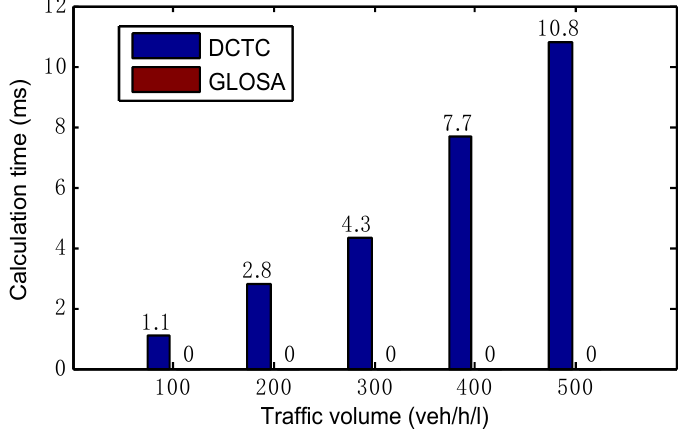
Figure 12. Calculation